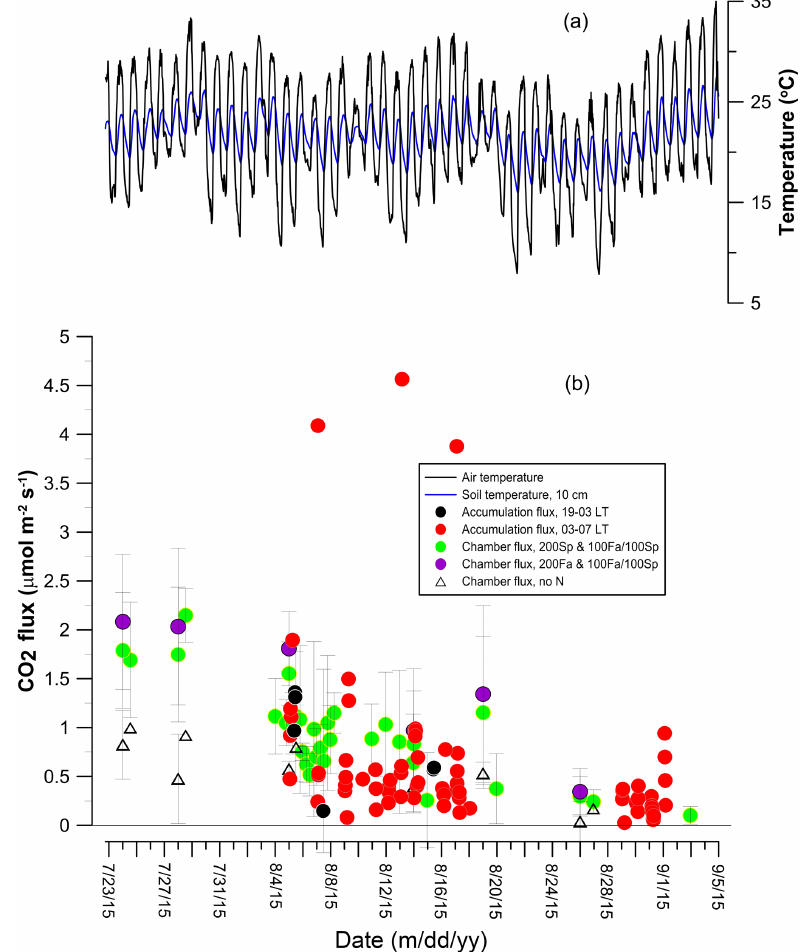
Figure 7. Temperatures and CO 2 flux based on accumulation and chamber methods. Diurnal variation in air (solid black line) and 10cm soil at 10cm depth (dashed blue line) during the period are indicated in panel a. Total fluxes (accumulative within and diffusive out the top of the control volume) under stable, low turbulence conditions and soil + root fluxes calculated using the chamber method are indicated in panel (b) (ordinate axis with differing units to left and right). The standard deviation of the three chamber flux measurements in each field is indicated by the vertical